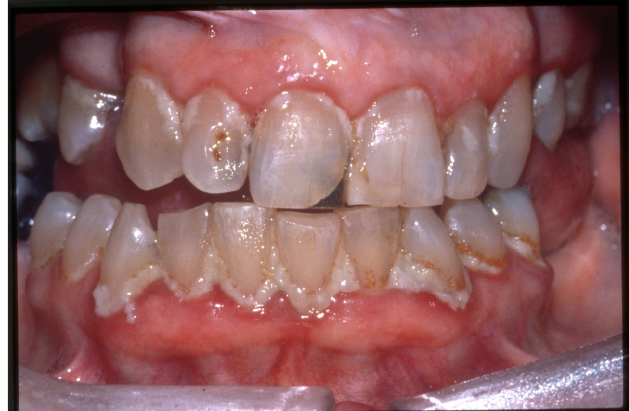
Figure 3. A 75-year-old male was brought to the clinic by his daughter and his wife. The patient has not seen a dentist regularly for the last five years. His wife complains that he is having difficulty eating hard foods. About six months ago, he suffered a cerebral vascular accident that affected the left side of his brain and left him with some weakness in his right side, including aphasia and difficulty walking. Since that time, he also has had difficulty with being able to brush his teeth independently. His other medical problems include hypertension, hypercholesterolemia, arthritis, and type II diabetes. His medications include clopidogrel, metformin, furosemide, potassium, simvastatin, and a calcium channel blocker. An intra-oral examination revealed a dry mouth, heavy plaque, and calculus, especially on the right side of his mouth, accompanied by multiple cervical and coronal carious lesions and marginal gingivitis. His treatment will require significant changes in his daily oral hygiene, which will require his wife to help him. This patient represents a person who has many important risk factors and shows multiple signs that he is developing rapid oral health deterioration.